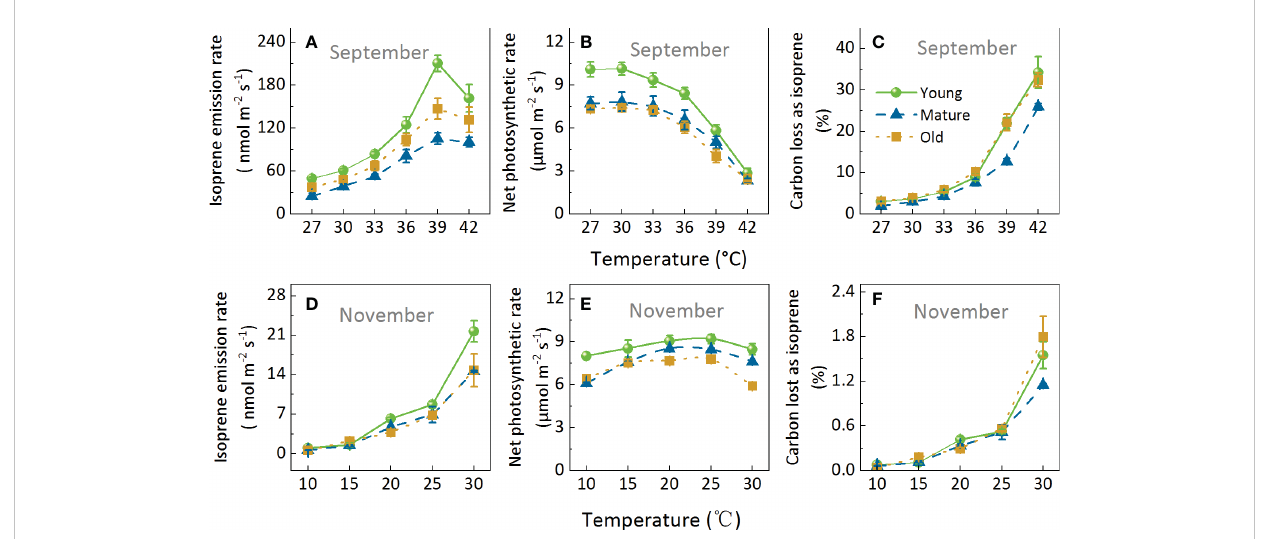
FIGURE 5 Effects of increasing temperature on isoprene emission rate (A, D) , net photosynthetic rates (B, E) , and carbon lost as isoprene (C, F) . Measurements were taken in September (A – C) and November (D – F) . During the measurements, ambient CO 2 concentration was set to 400 m mol mol -1 , and photosynthetic photon fl ux density (PPFD) was 1000 m mol m -2 s -1 Data are mean ± SE (n = 3 –